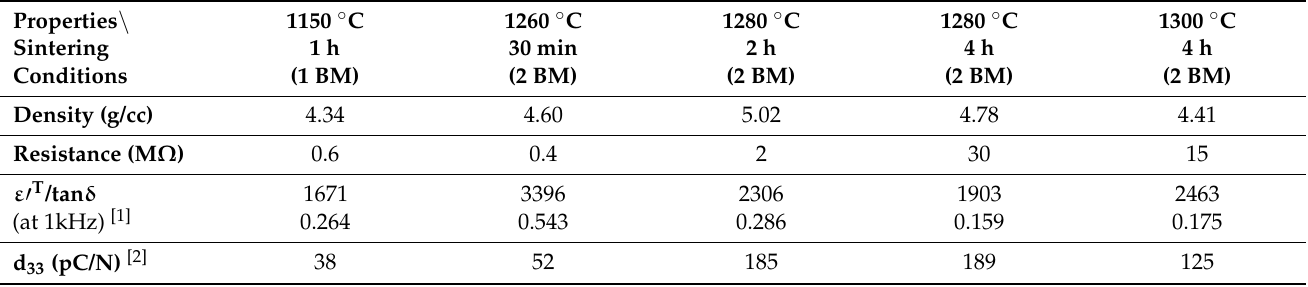
Table 2. Some properties of the sintered ceramic disks, after synthesis at 700 ◦ C for 30 min., under variable time and temperature using a single sintering